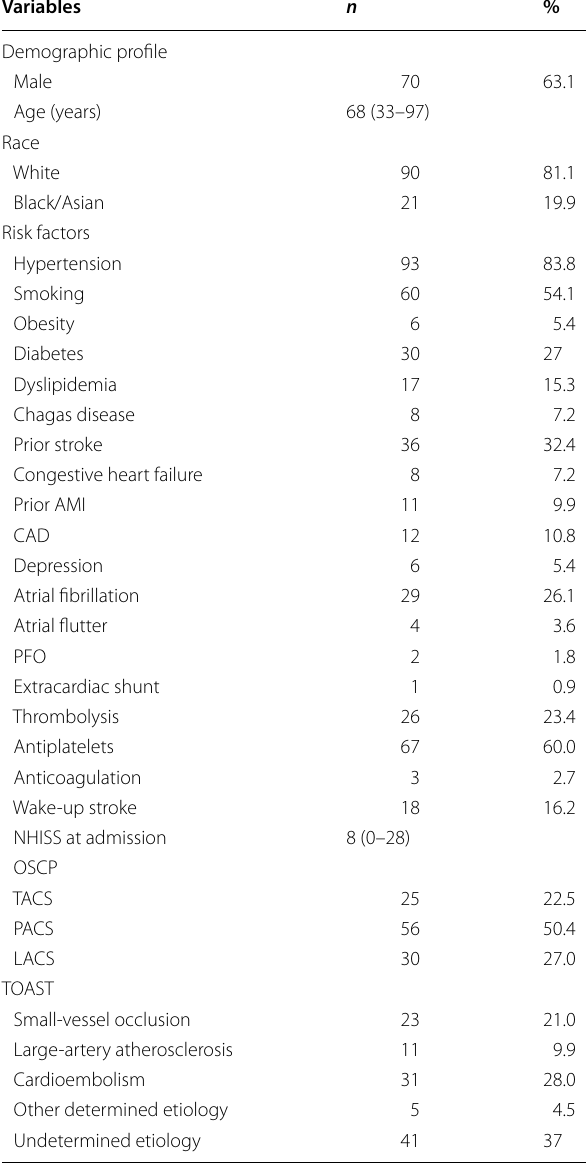
Table 1 Demographic profile, key risk factors, and